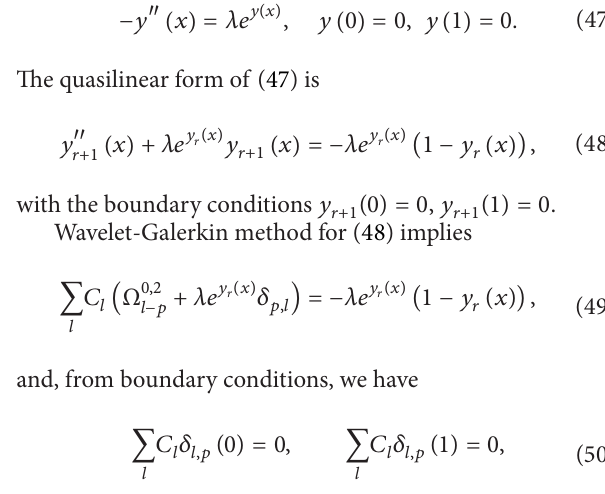
Table 2: Comparison of exact solution 𝑦 , solution by decompo- exact , and solution by the wavelet-Galerkin method sition method 𝑦 DM at second iteration and 𝐷12 with quasilinearization technique 𝑦 NEW is used as Galerkin